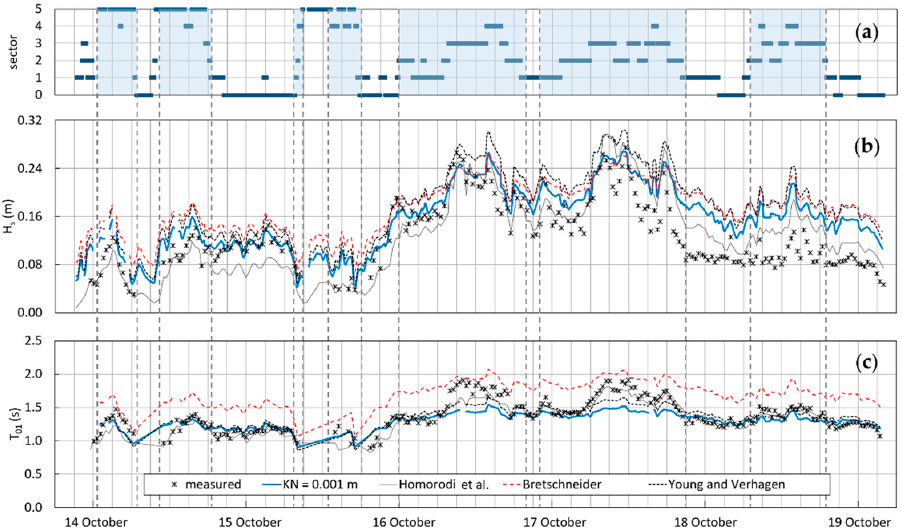
Figure 9. October 2005: ( a ) sectors of blowing winds with the selected colored records that correspond to fully developed wave conditions; ( b ) significant wave heights; ( c ) mean wave periods. Asterisks indicate measured data; the bold blue line indicates the results given by the growth curve with K N of 0.001 m, the dashed red line the forecasting values obtained with the Bretschneider formula, and the black dotted line those obtained with Young and Verhagen formula.